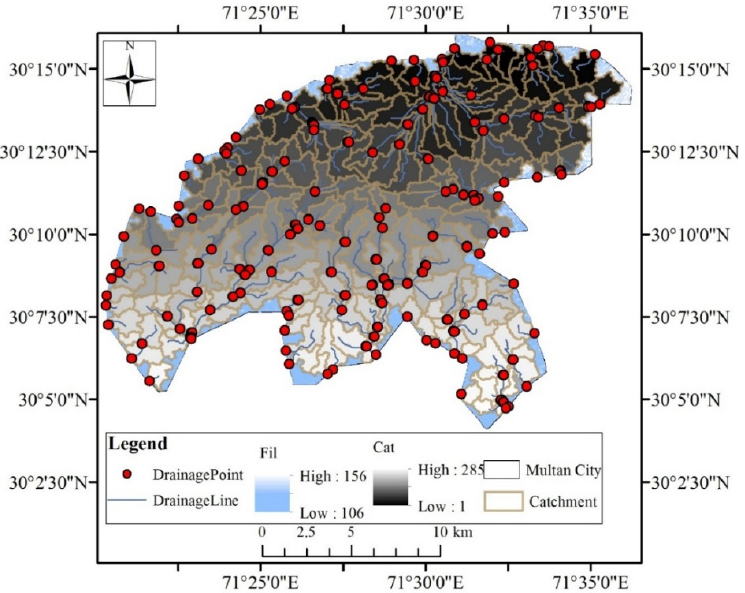
Figure 2. Natural hydrologic system of drainage point, drainage line, fil, adjoining catchment, and catchment polygons.